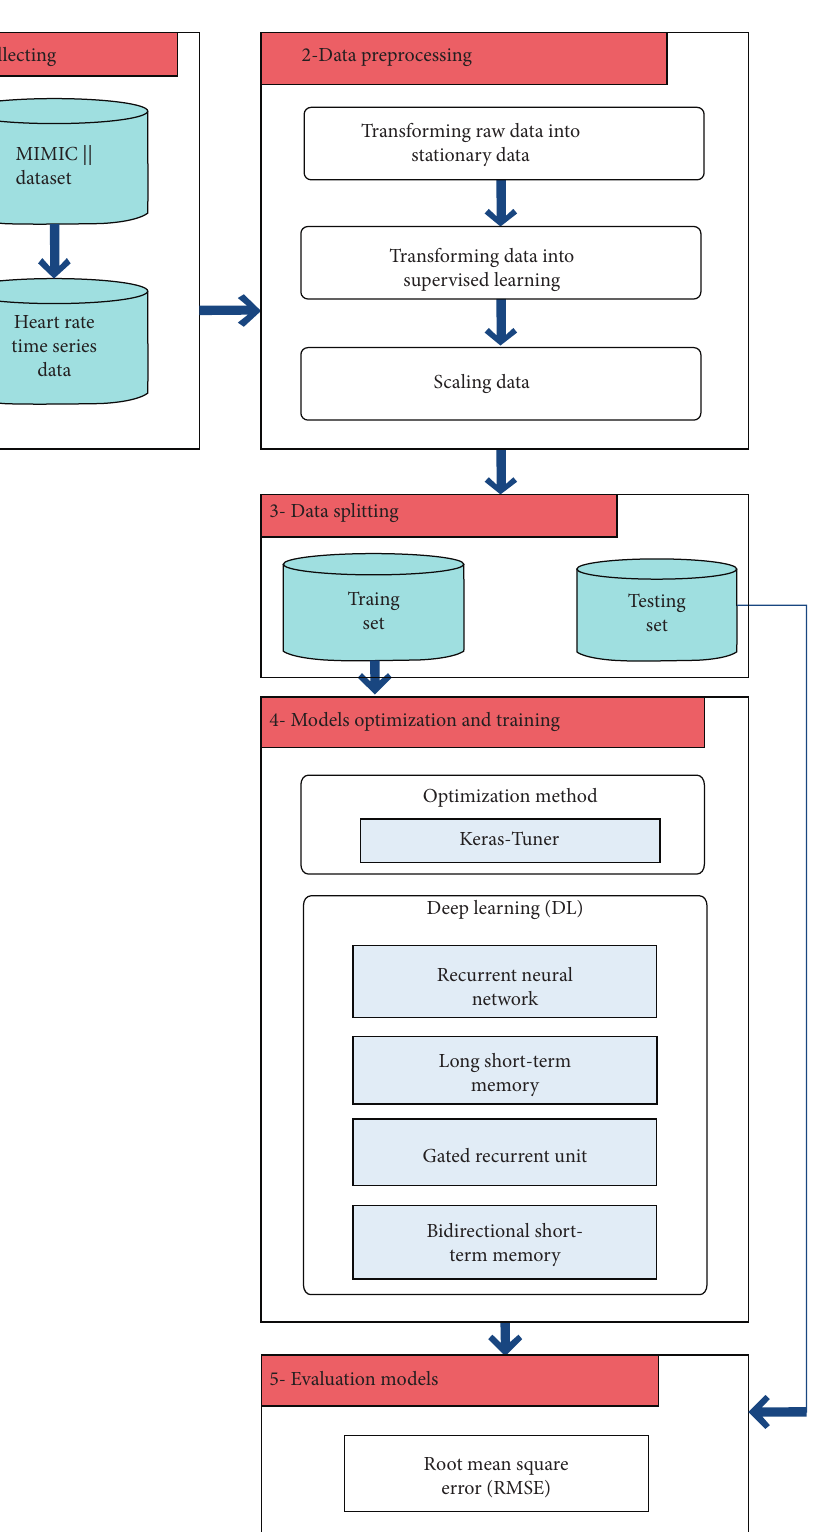
Figure 2: The architecture of the offline